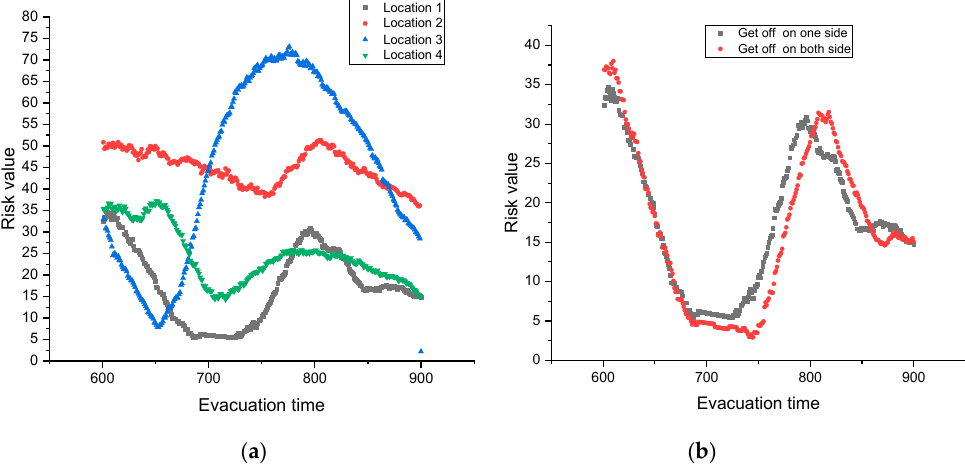
Figure 7. Pedestrian evacuation risk under different scenarios: ( a ) different stampede locations, ( b ) different “get off” ways.